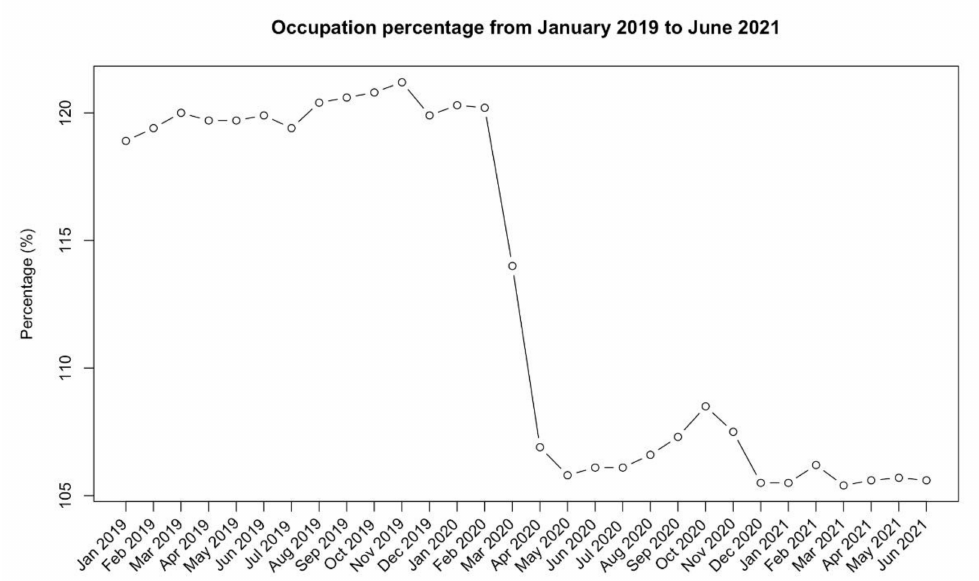
Figure 1. Occupation percentage in Italian prisons from January 2019 to June